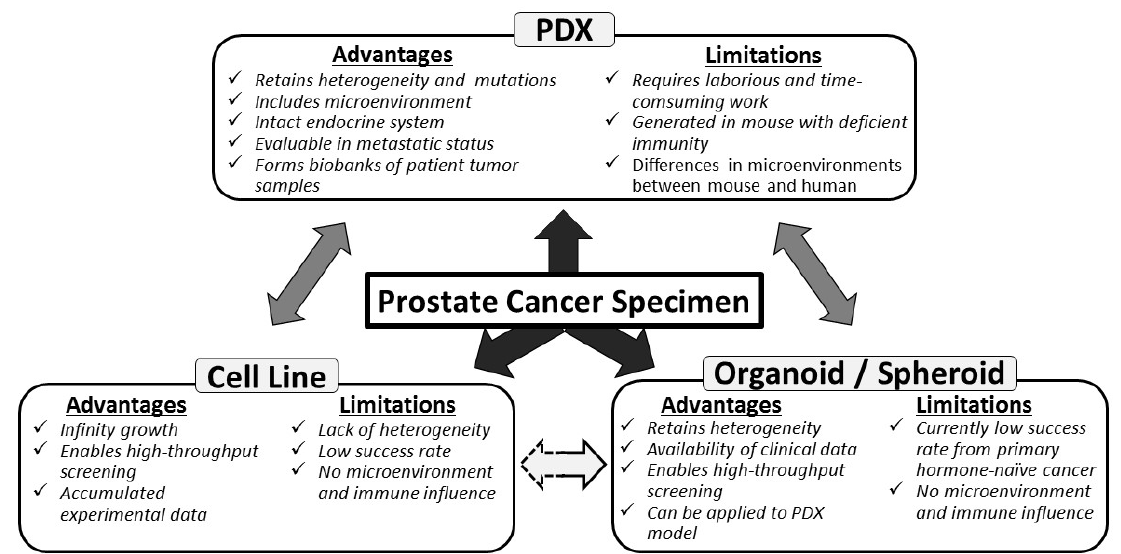
Figure 1. Application of prostate cancer models for preclinical study derived from fresh patient specimens. Each platform has its own advantages and limitations in terms of study design and expected outcome. Traditional cell lines are usually established from metastatic lesions and basically adapted to 2-dimensional monolayer culture. In contrast to cell line platform, recently developed platforms of patient-derived xenograft (PDX) and patient-derived cancer cells (PDCs) in 3-dimensional organoids/spheroids have advantages, as they often retain the characteristics of the original tumor including tumor heterogeneity and complexity. PDX models have advantages, including microenvironment, but limitations due to immunodeficient host background. PDCs can be